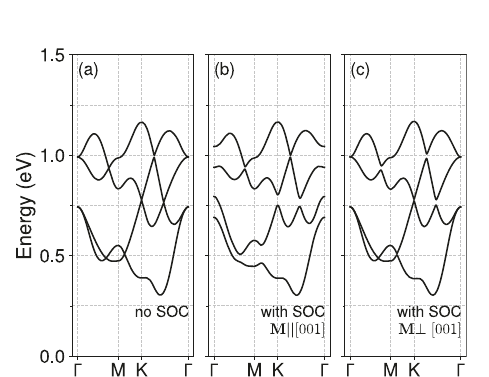
represent onsite